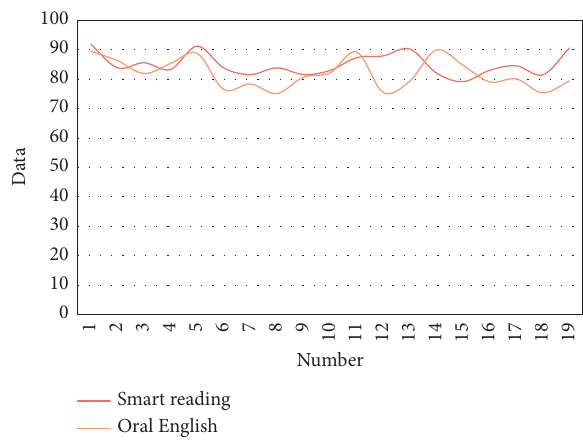
Figure 9: Statistical diagram of the evaluation of English reading and spoken